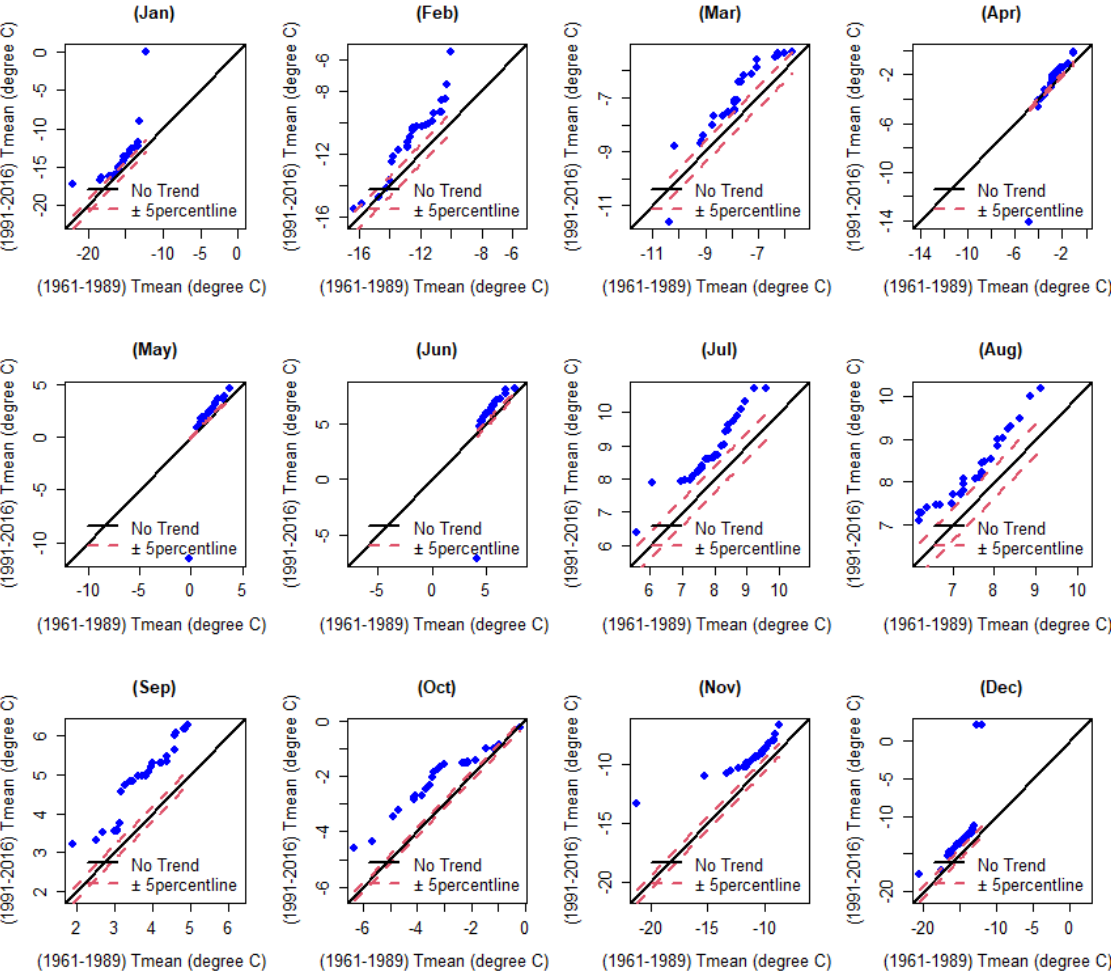
Figure 6. Monthly graphical representation of ITA results for mean temperature time series (1961 – 2016).